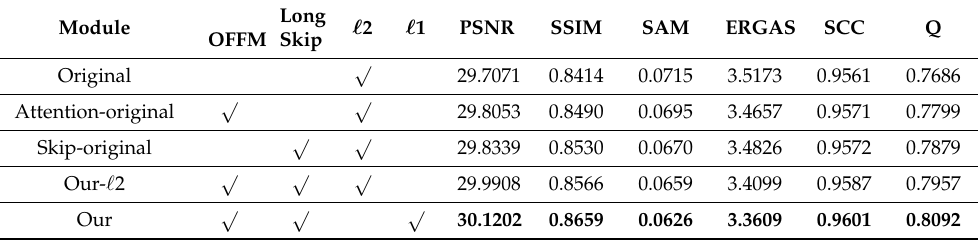
Table 2. The results of ablation experiments on the GaoFen-2 dataset (bold indicates the best results). Long Module OFFM